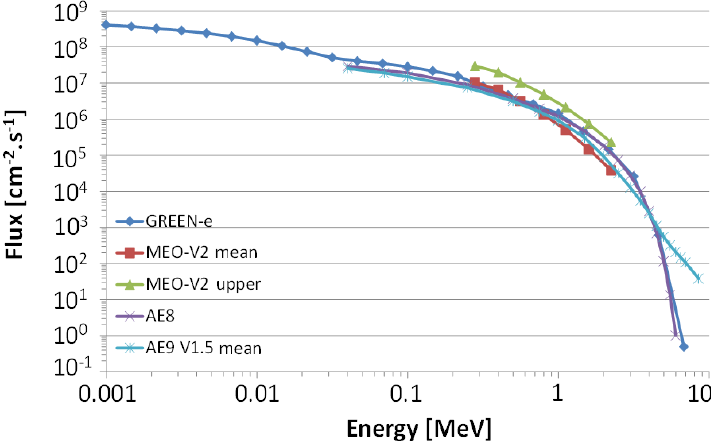
Figure 15. Electron spectrum from GREEN- e (in blue) in a whole solar cycle compared to the mean (in red) and upper (in green) flux provided by the MEO-V2 model.